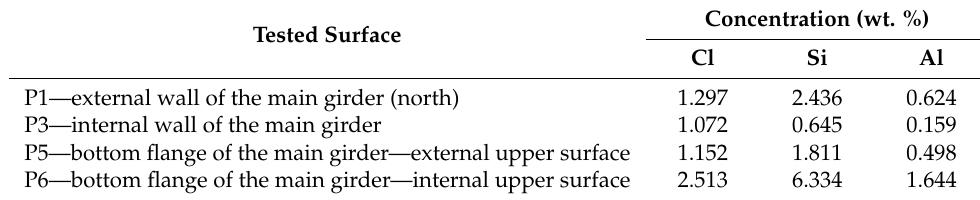
Table 3. Composition analysis—samples withdrawn from surfaces of bridge No.